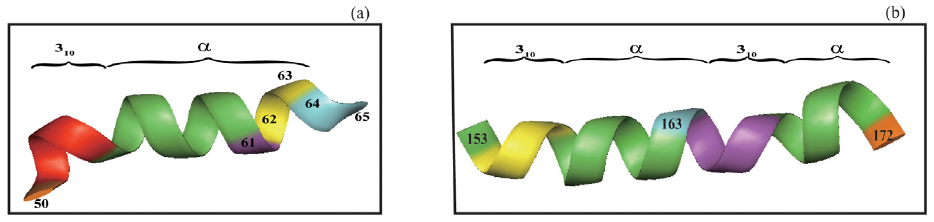
Fig 5. The illustration of the differences in assignment by our algorithm and DSSP . In (a) DSSP assigns the entire segment (51 – 65, excluding P50) in a protein (pdbid 3OY9) as an α -helix. Our algorithm divides it into two helices: 3 10 -helix (51 – 52, red) and α -helix (53 – 63, green, purple, yellow). The α -helix stops at N63 since the C α RMSD δ values for residue 64 and 65 are respectively 0.541, 0.431, none of them less than d max = 0.3. In contrast, the DSSP assigned helix extends to residue 65. However, as shown in the left figure, the C α coordinates of both residue 64 and 65 deviate clearly from a helical curve. In (b) a segment of residues 153 – 172 in a protein (pdbid 1MHY) is assigned as a single α -helix by DSSP while our algorithm divides it into four helices: 3 10 -helix(154 – 156, yellow) – α -helix(157 – 163, green) – 3 10 -helix(164 – 166, purple) – α -helix(167 – 171, green). However, a careful examination of the hydrogen bond energies for these residues in fact suggests that they could also be assigned to a 3 10 -helix even by the DSSP standard (S2